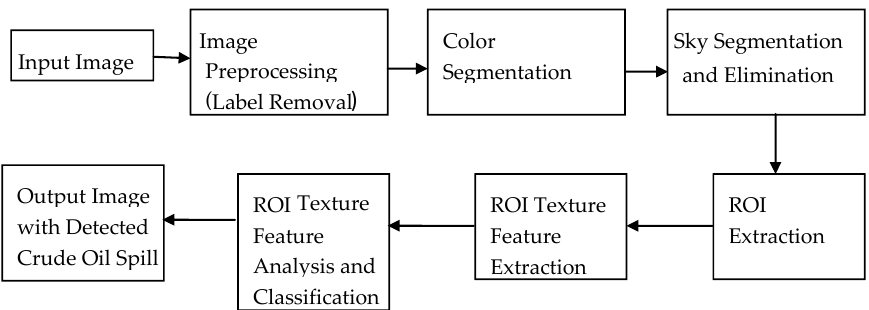
Figure 2. Land Crude Oil Spill Detection Algorithm.